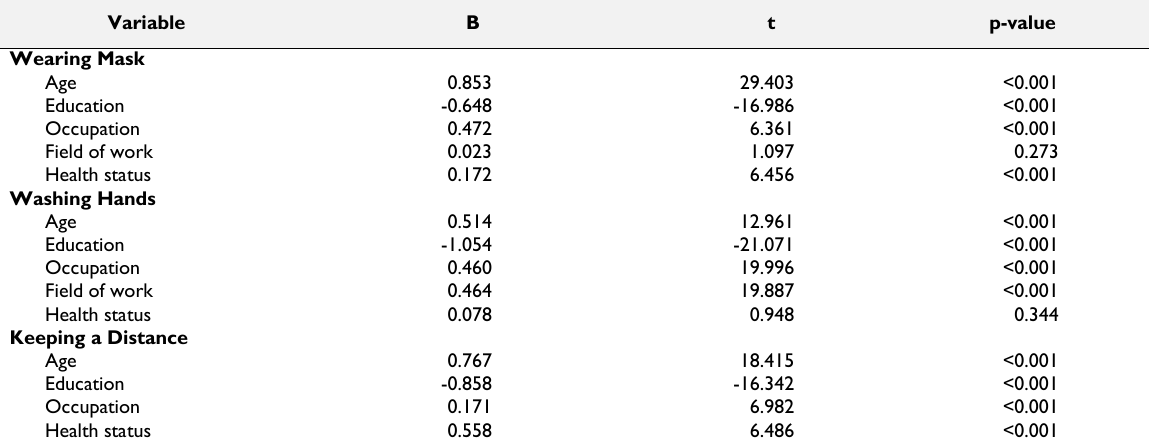
Table 4 The results of data analysis of age, education, occupation and health status on the health protocol adherence Variable